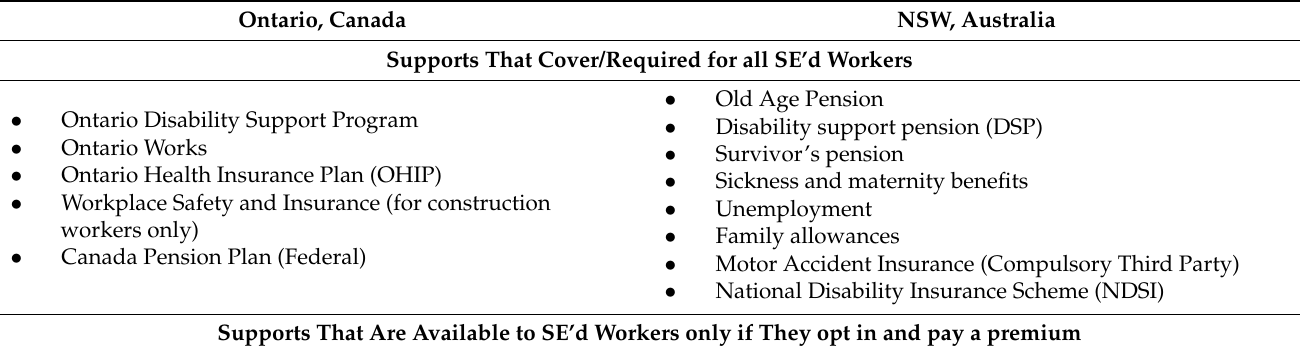
Table 5. Government and Non-Government Supports for SE’d Workers following illness or